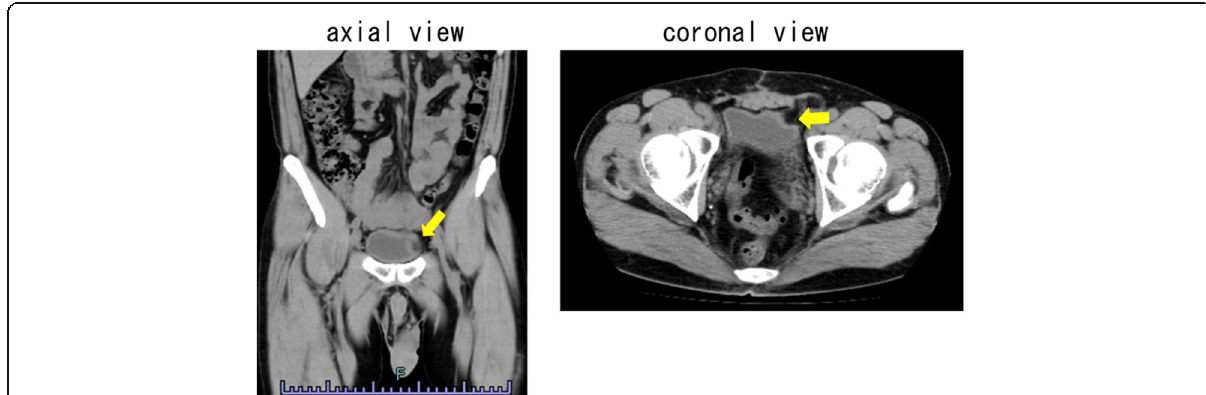
Fig. 3 Abdominal CT findings 3months after the operation showed inversion of the bladder left wall (arrow), but no bowel invagination was